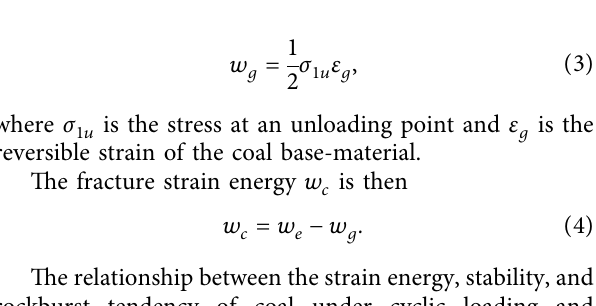
Figure 4: Classification and calculation of strain energy.